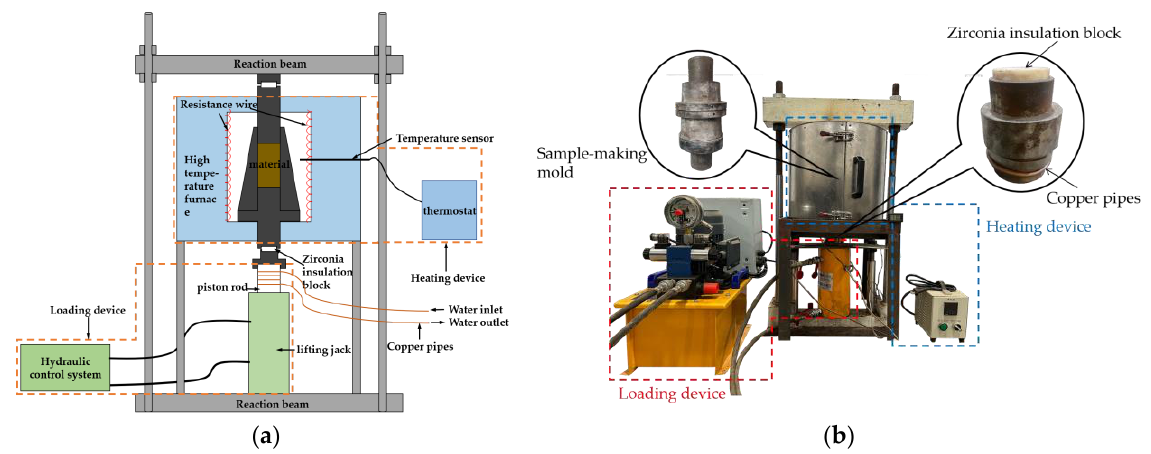
Figure 3. ( a ) Schematic diagram of the sample preparation system; ( b ) Physical view of the sample preparation system.